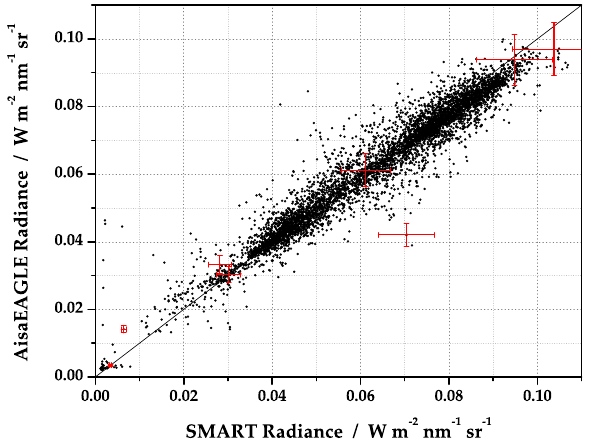
Fig. 4. ECMWF analysis chart (925hPa, 12:00UTC) and SoRPIC flight track (in red) on 17 May 2010, from Longyearbyen (LY) to 50km east of Bjørnøya (B) and back. Dropsondes were launched at the D symbols. The contours are the geo-potential height in m (green) and the equivalent potential temperature in K